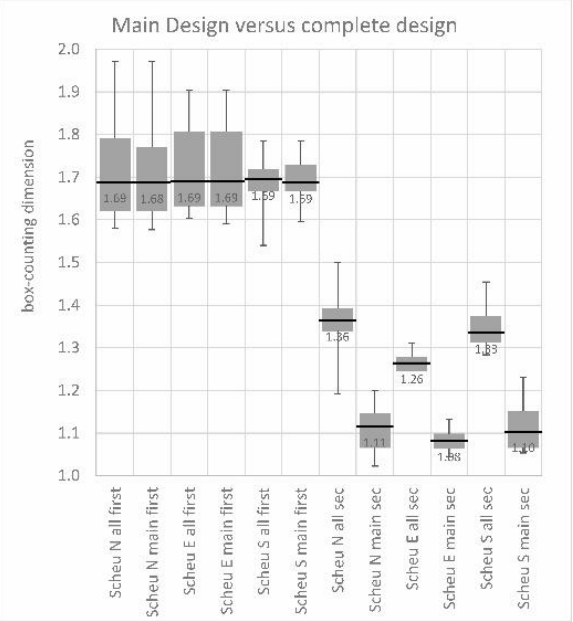
Figure 15. Comparison Main Design and entire design (including e.g., frames of windows).